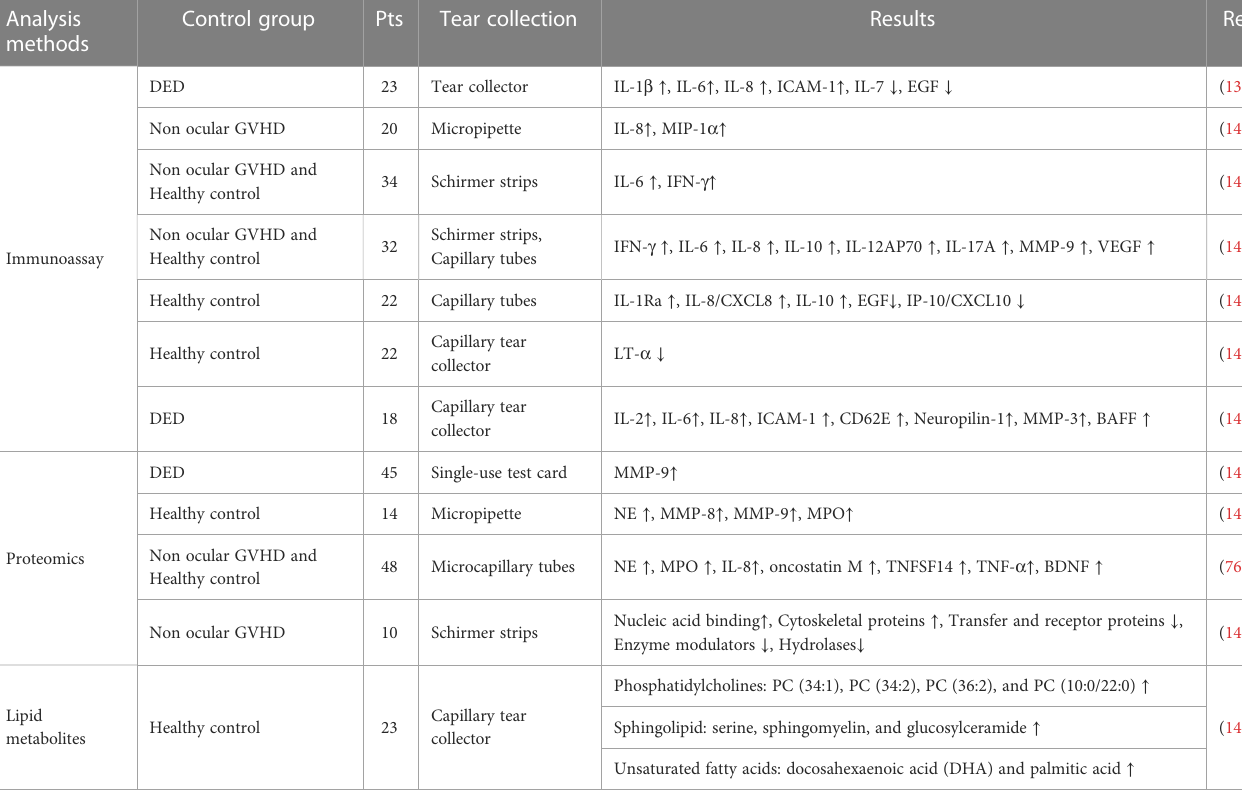
TABLE 2 Summary of data from the studies investigating tear molecules in ocular GVHD. Analysis